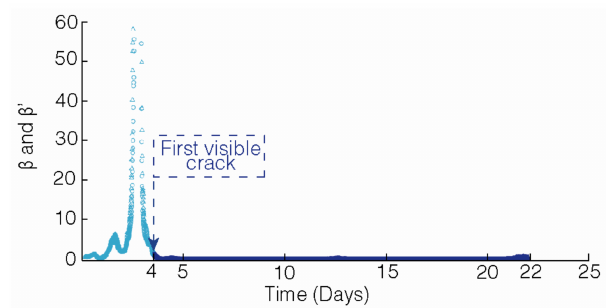
Figure 9. Evolution of the nonlinearity parameters (derived from the non-linear ultrasonic (NLU) measurements) along the duration of the forced corrosion test of specimen M3. β :